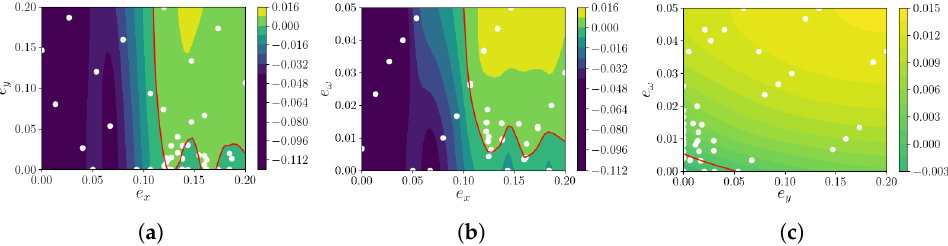
Figure 4. Conformance measure with respect to parameters as approximated by gp conf . The red line is the boundary between conformant and non-conformant parameters. ( a ) e x vs. e y , e ω constant. ( b ) e x vs. e ω , e y constant. ( c ) e y vs. e ω , e x constant.